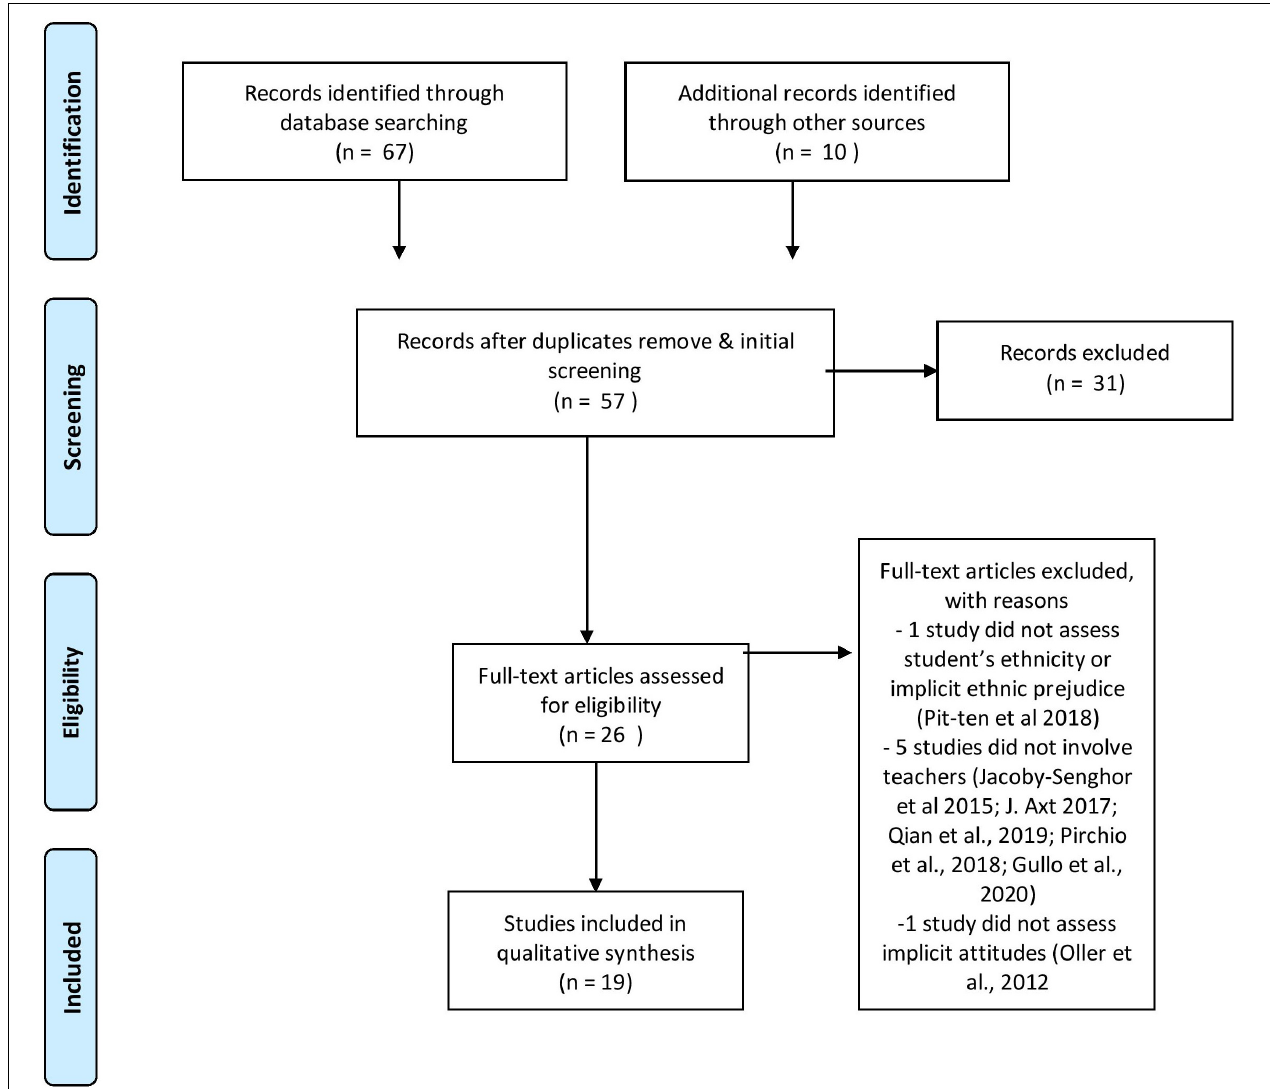
FIGURE 1 | Schematic presentation of selecting studies for systematic review (in accordance with PRISMA guidelines; Moher et al.,